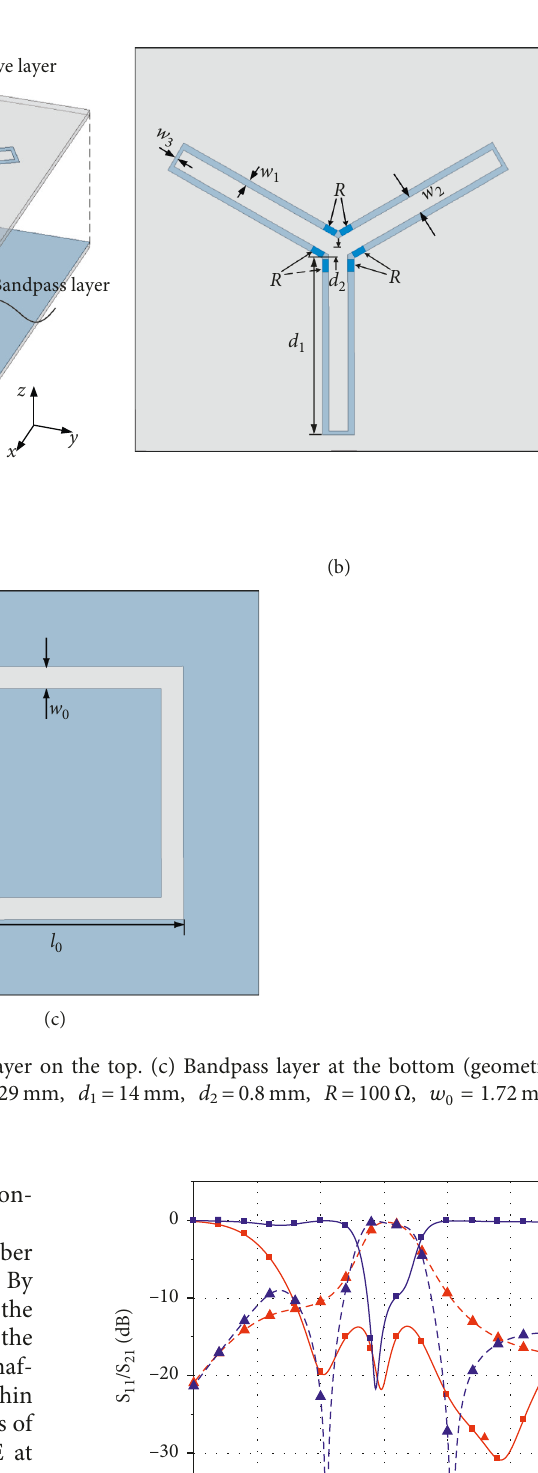
Figure 3: Reflection/transmission coefficients of the rasorber with 100 Ω and 0 Ω